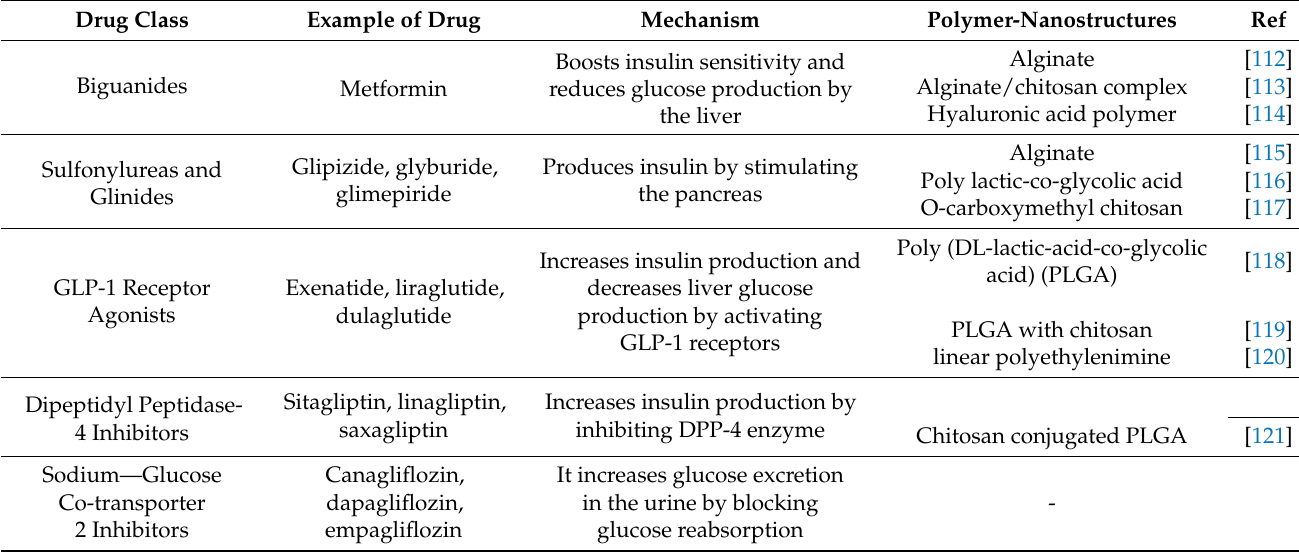
Table 2. An overview of antidiabetic drugs, their mechanisms of action, and examples of nanostruc- tures to improve their drug